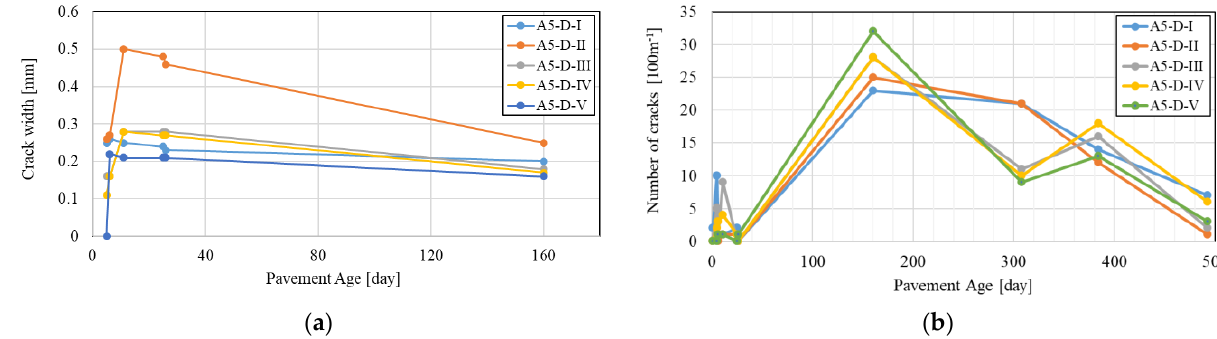
Figure 5. Formation of cracks on five different sections of A5 near Darmstadt: ( a ) development of crack width; ( b ) number of cracks per 100 m.